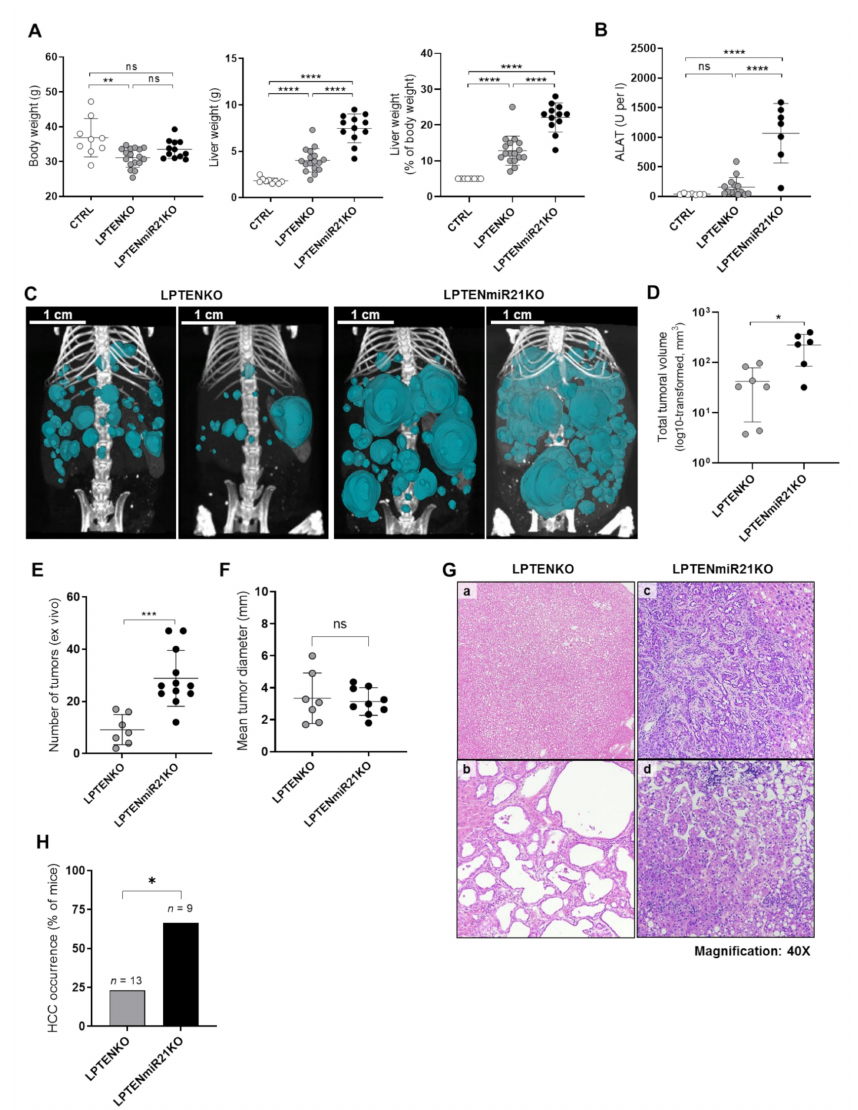
Figure 3. Hepatocyte-specific miR-21 deletion promotes exacerbates hepatocarcinogenesis induced by PTEN deficiency. ( A ) Body weight, liver weight, and liver-to-body weight ratio of control (CTRL—floxed mice not expressing the Alb-Cre recombinase, n = 9), hepatocyte-specific PTEN knockout (LPTENKO ( n = 17), and LPTENmiR21KO ( n = 12),